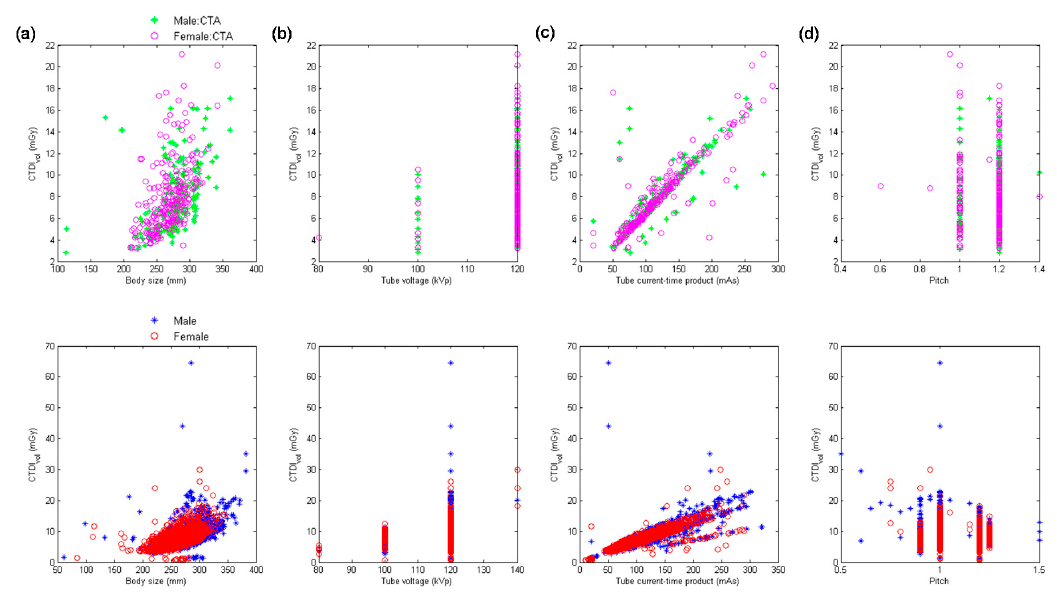
Figure 2. Scatter plots of CTDI vol versus ( a ) body size, ( b ) kVp, ( c ) mAs, and ( d ) pitch for chest CTA scans ( upper row) and chest scans excluding CTA ( lower row) performed using MDCT 64 . Table 5. Results of multivariate analysis for the chest scans performed using MDCT 64 .